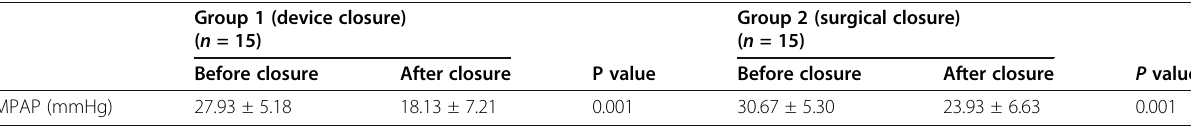
Table 4 PAP in device and surgical